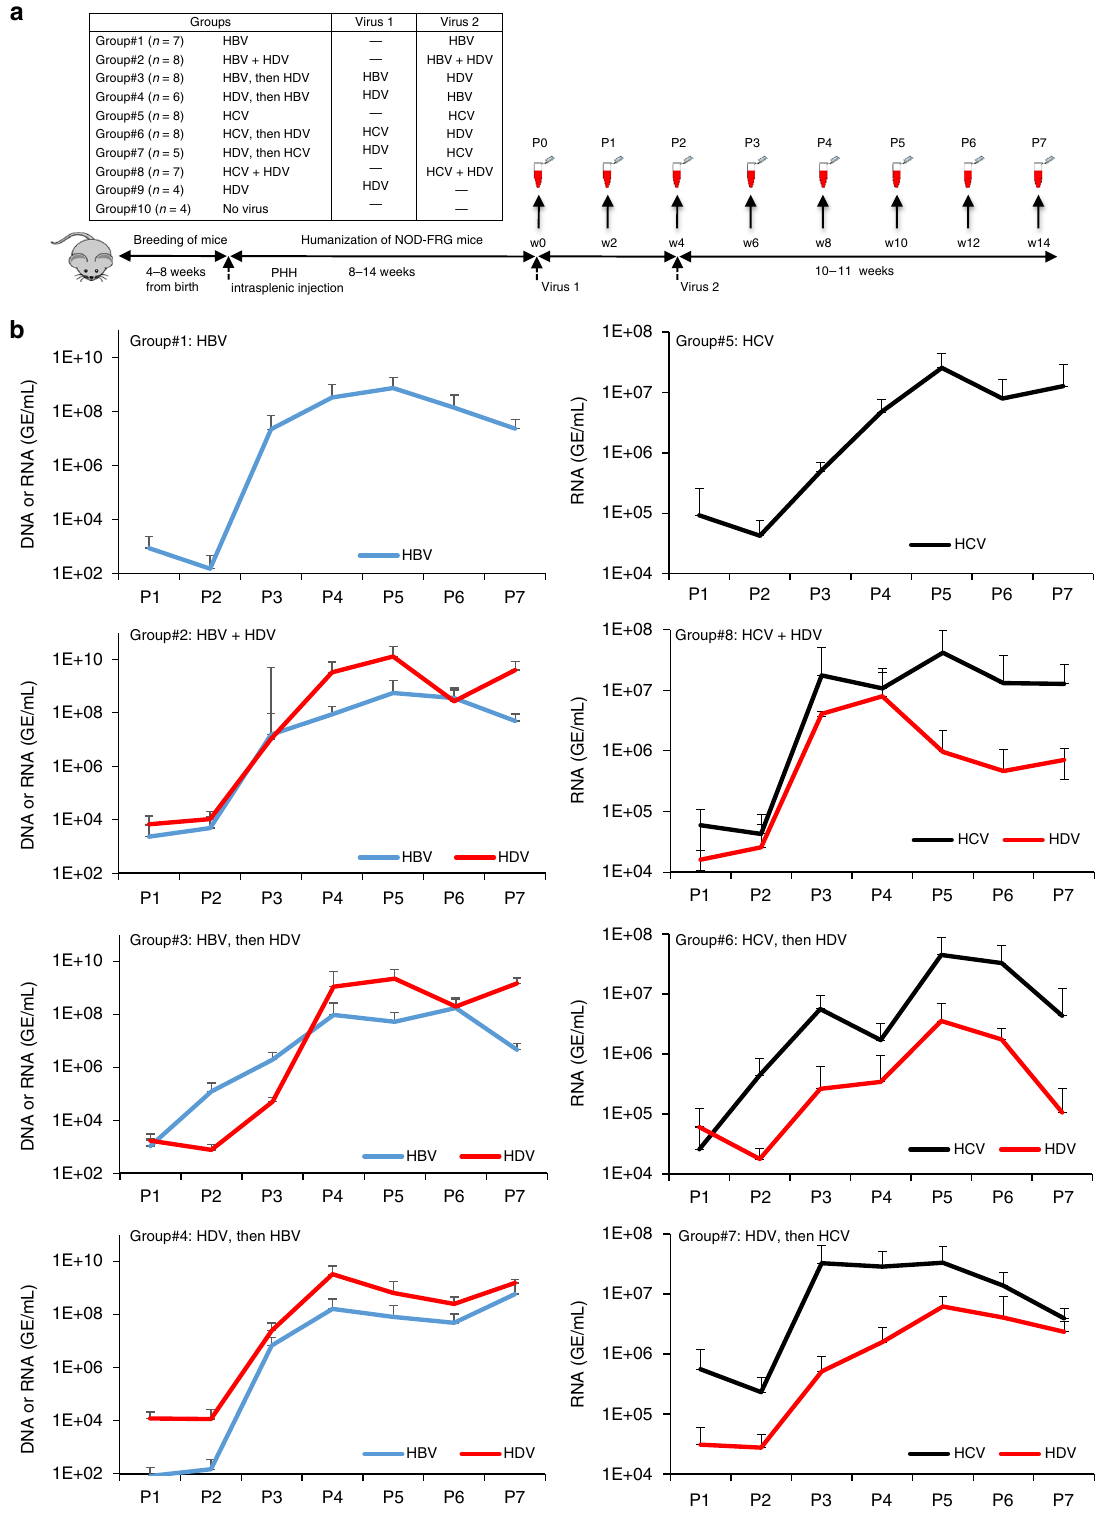
Fig. 7 HCV propagates HDV particles in vivo. Four- to eight-week-old NOD-FRG mice were engrafted with primary human hepatocytes (PHH). After ca. 2 – 3 months, the animals displaying HSA levels >15 mg/mL were split into 10 different groups ( n = 4 to n = 8 independent animals) that were infected with HDV (10 7 GE/mouse) and/or HCV (1.5 × 10 5 FFU/mouse) or HBV (10 8 GE/mouse), as shown in the schedule ( a ). At different time points post infection, blood samples (50 µ l) were collected and the viremia in sera was monitored by qPCR on the genomes of the indicated viruses (GE/mL of serum) ( b ). The graphs show the mean results of viremia of HDV (red lines), HBV (blue lines), and HCV (black lines). See results of individual mice as well as of control groups, inoculated with HDV only (Group#9: HDV) or with PBS (Group#10: Mocks) in Supplementary Fig. 7. Source data are provided as a Source Data fi le. Error bars correspond to standard